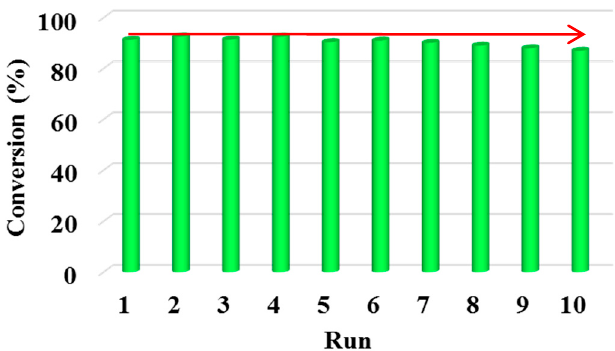
Figure 11. Reusability of MSA/UiO-66 in the esterification of PA with n -decanol.